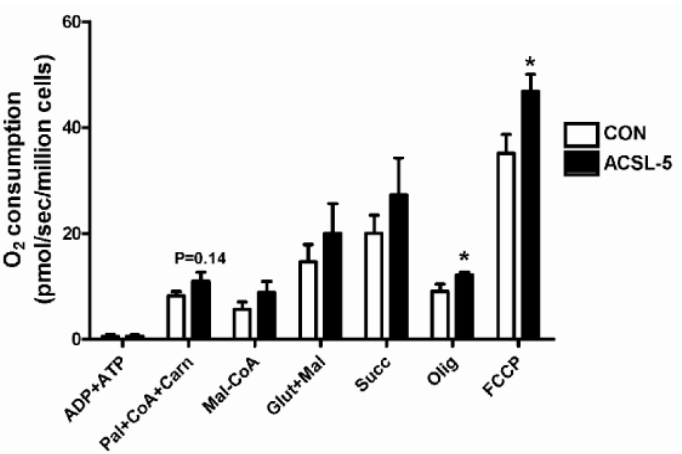
Figure 3. Effect of ACSL-5 overexpression on mitochondrial oxygen consumption measured in permeabilized primary human skeletal myotubes. The following multiple substrate protocols were commenced for mitochondrial O 2 consumption: (i) 2 mM ADP/0.5 mM ATP (state 3 following addition of substrates), (ii) 0.1 mM palmitate + 0.1 mM CoA + 1 mM carnitine (fatty acid substrates, state 3), (iii) 0.1 mM malonyl-CoA (CPT-1 inhibitor, state 3), (iv) 2 mM glutamate + 1 mM malate (complex I substrates, state 3), (v) 3 mM succinate (complex II substrate, state 3), (vi) 10 µ g/mL oligomycin (inhibitor of mitochondrial ATP synthase, non-ADP stimulated basal state 4), and (vii) 2 µ M carbonylcyanide-p-trifluoromethoxyphenylhydrazone (FCCP, a protonophoric uncoupler, maximal uncoupled respiration) (open bar, control cells; closed bar, ACSL-5 transfected cells). The rate of O 2 consumption was expressed as pmol/sec/million cells. Data are presented as mean ± SEM (n = 6). * p < 0.05 versus control